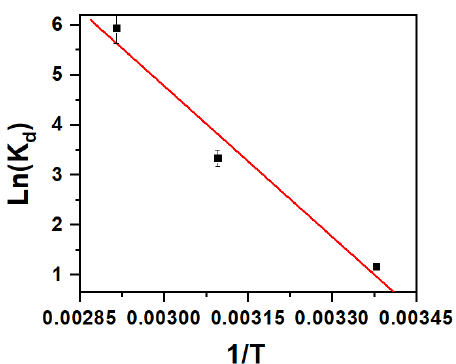
Figure 5. Van ’t Hoff plot showing the effect of temperature on MB removal by Fe 2 (MoO 4 ) 3 . Figure 5. Van ’t Ho ff plot showing the e ff ect of temperature on MB removal by Fe 2 (MoO 4 ) 3 . Table 1. Methylene blue (MB) removal by Fe 2 (MoO 4 ) 3 thermodynamic Table 1. Methylene blue (MB) removal by Fe 2 (MoO 4 ) 3 thermodynamic parameters.